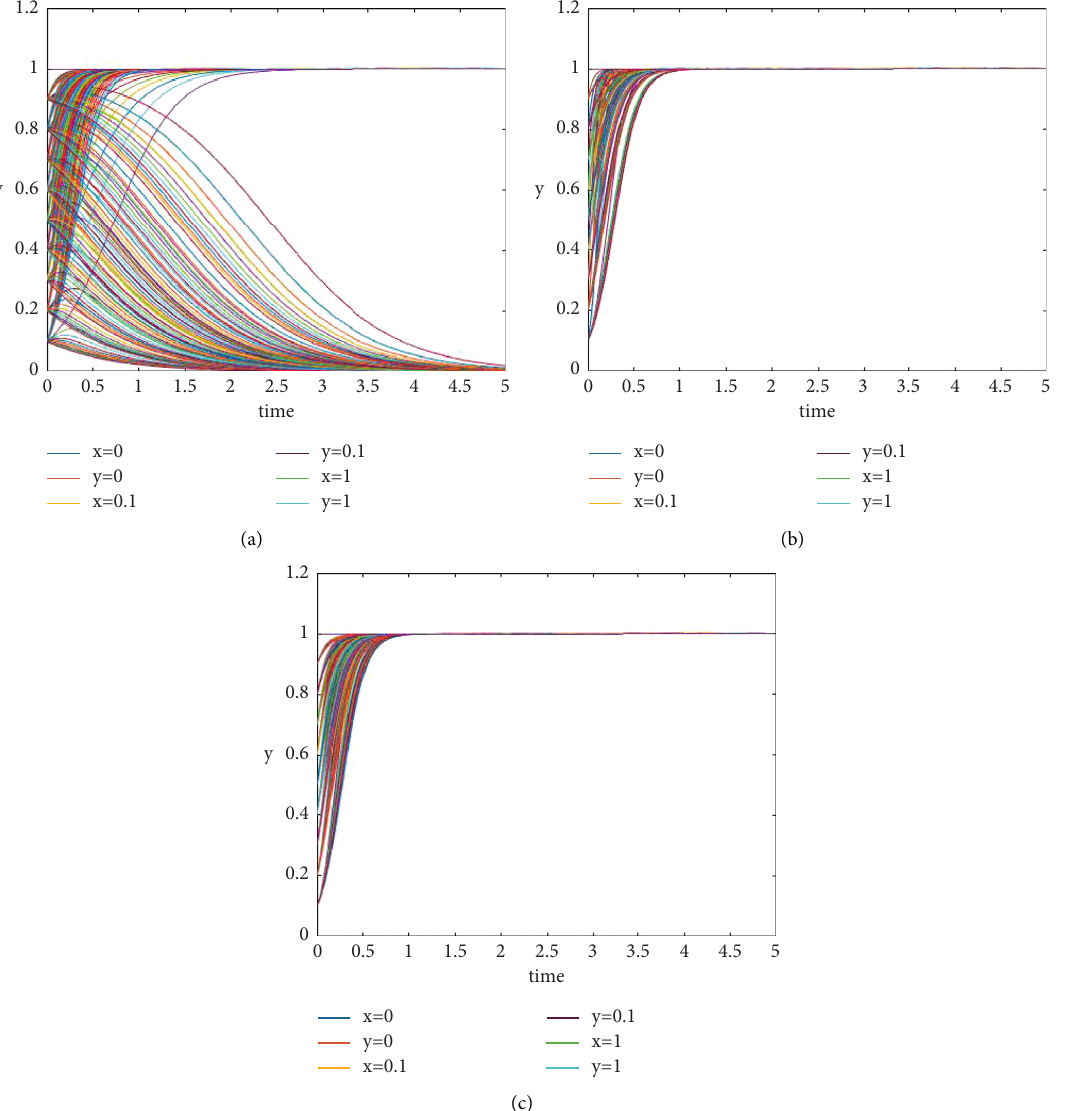
Figure 8: Evolution of the state of choice of air pollution control behaviour in the Beijing-Tianjin-Hebei region without